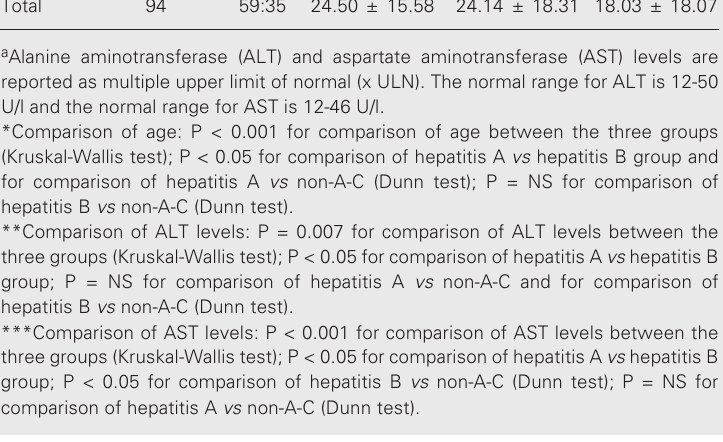
Table 1. Clinical features of the 94 patients studied. Group